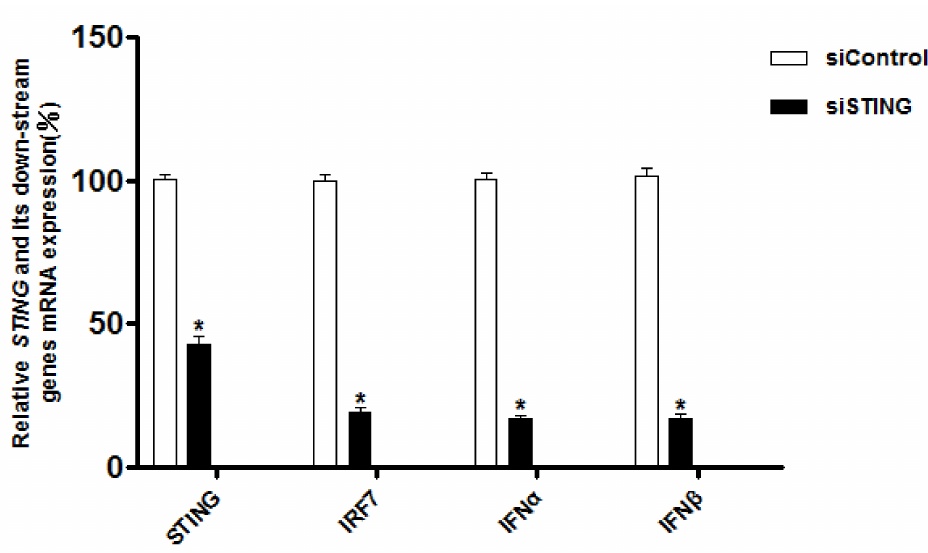
Figure 5. The expression levels of STING and its down-stream genes after interference with the STING gene. Mean ± standard deviation (SD, n = 3) of three biological replicates are shown. (*) p < 0.05. 3.3.2. Expression of STING and Its Down-Stream Genes after In Vivo Infection by NDV